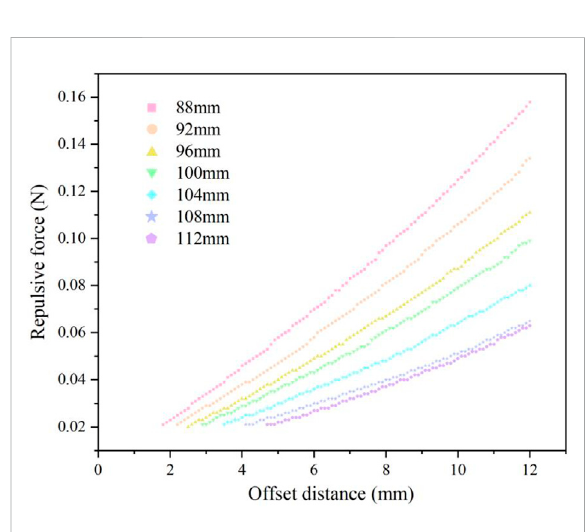
FIGURE 9 Measured repulsive forces for different offset distances with various rod lengths.